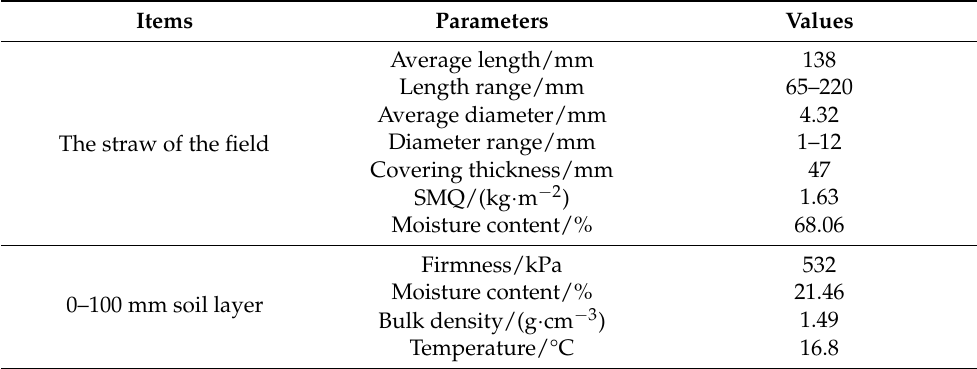
Table 5. Main parameters of field